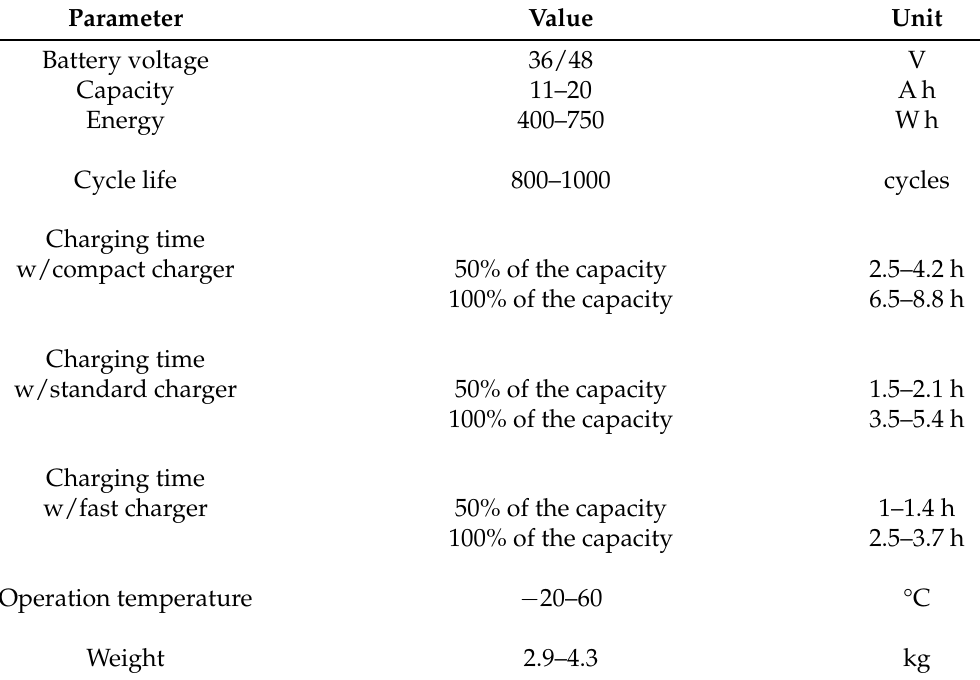
Figure 8. Scheme of a typical integrated battery. Table 1. Integrated battery specifications for e-bike